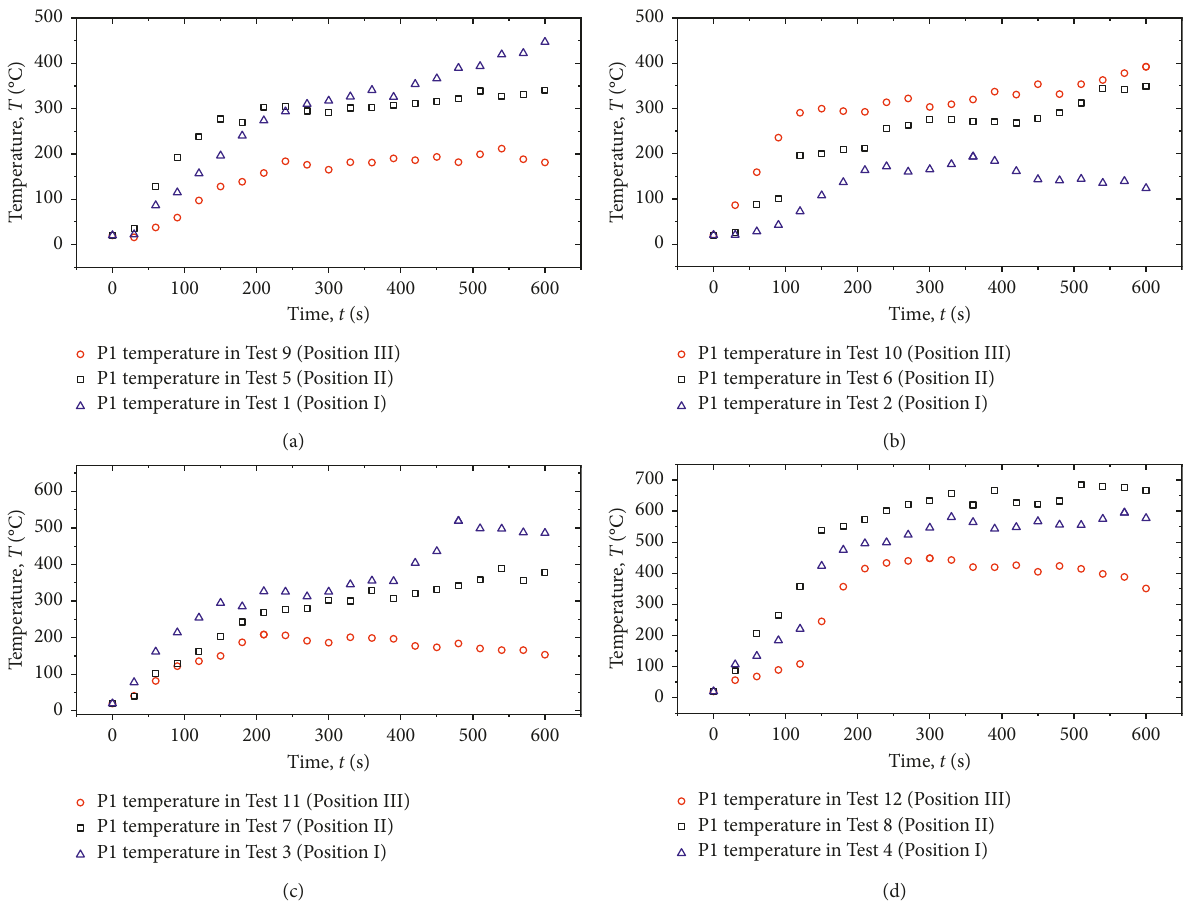
Figure 9: Temperature increase in the tunnel. (a) V 1